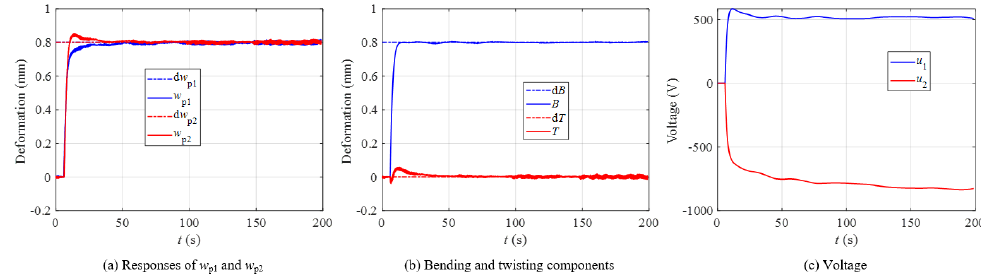
Figure 13. Pure bending shape control performance. ( a ) The deflection histories of the two measurement points; ( b ) the time histories of B and T ; ( c ) the time histories of the voltages for the two MFC actuators.